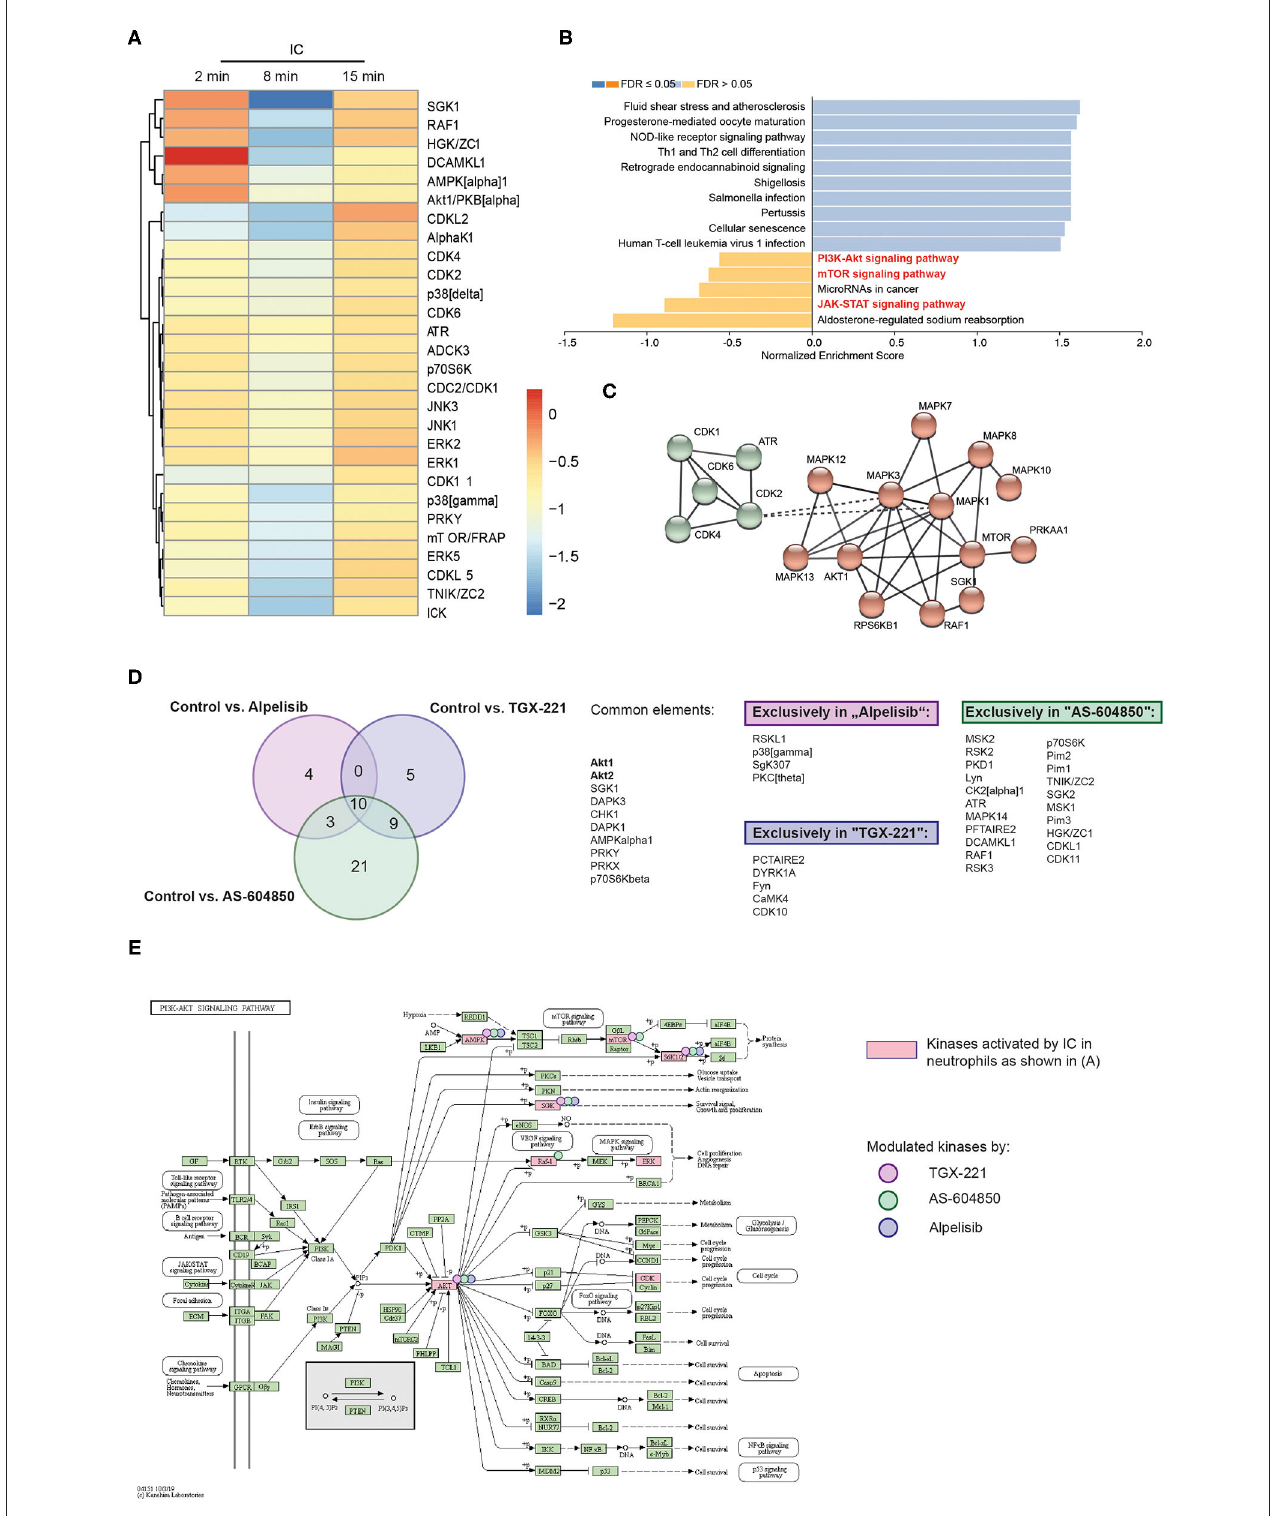
FIGURE 5 | Unique impact of different PI3K inhibitors on downstream kinase activation. Freshly isolated human blood PMNs were activated with IC for 0, 2, 8, or 15min. Cells were lysed and the PTK and STK activity was measured by PamGene. (A) Heatmap of mean kinase statistic in comparison to unstimulated cells (0min). Blue: Kinase activity decreased/Red: Kinase activity increased. (B) Enriched KEGG pathways (as shown by Webgestalt) after IC-stimulation. (C) String network for